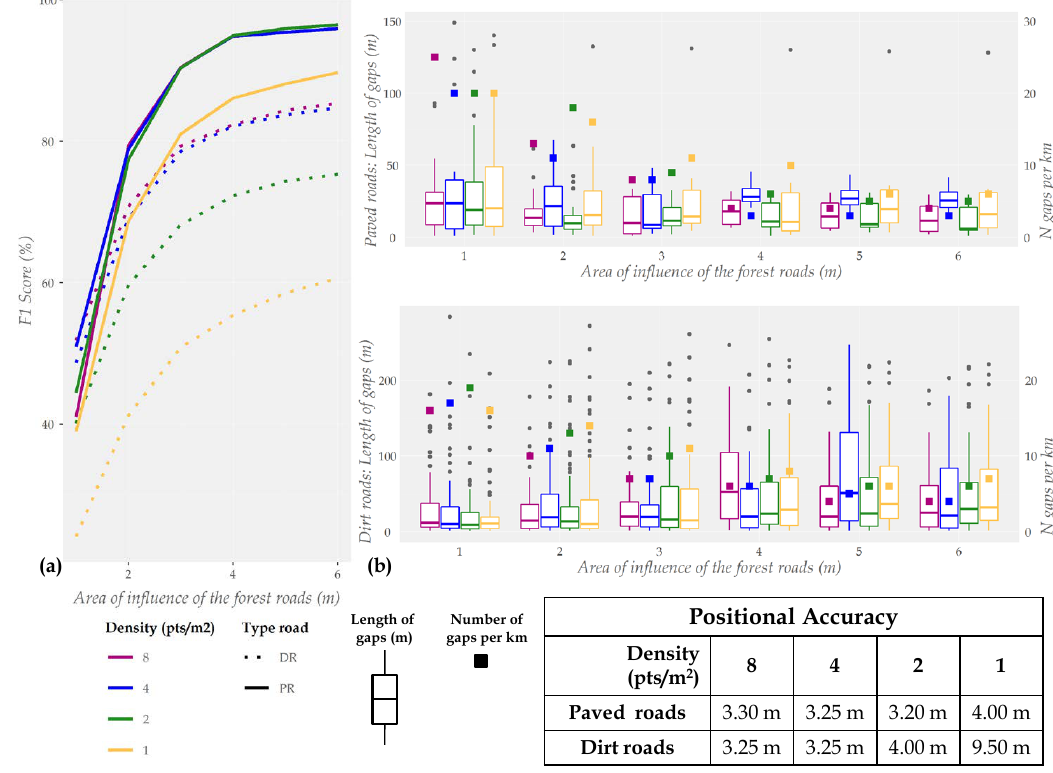
Figure 14. Results of ( a ) F1 score (%), ( b ) length of gaps (m) (boxplots) and the number of gaps per kms (square) for different sizes of influence area of the forest roads and the positional accuracy (m) for point clouds with densities 8, 4, 2 and 1 point/m 2